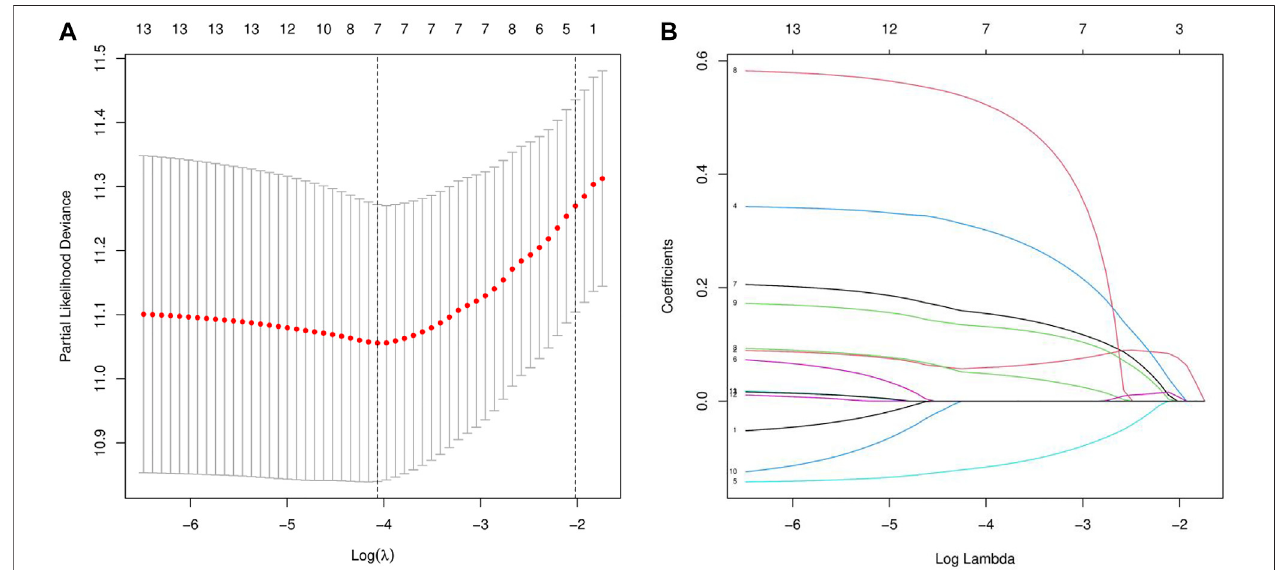
FIGURE 3 | LASSO regression analysis for the screening of immune-related differentially expressed genes (DEGs). (A, B) least absolute shrinkage and selection operator (LASSO) regression complexity was controlled by lambda via the R package “ glmnet ” .